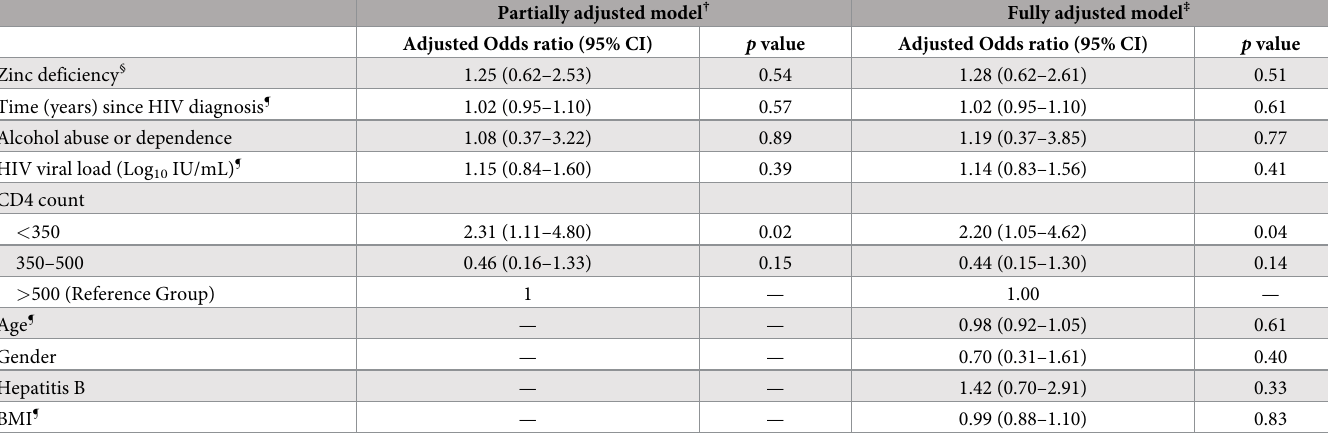
Table 2. Association between zinc deficiency and advanced liver fibrosis, logistic regression models.